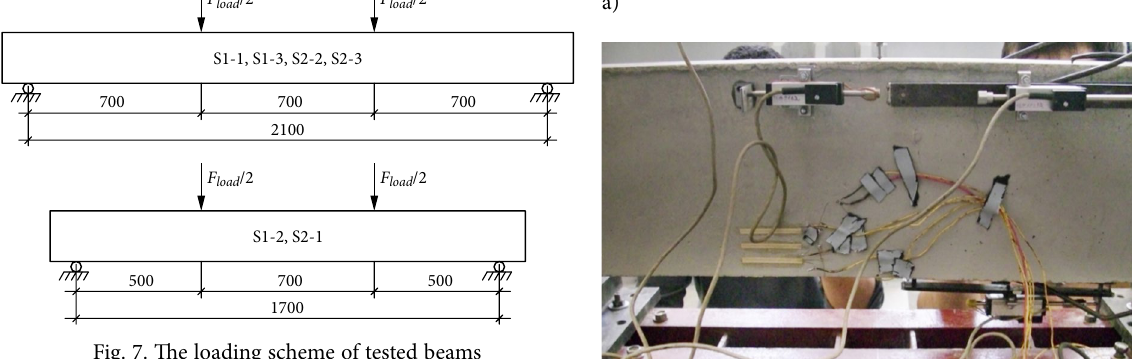
Fig. 7. The loading scheme of tested beams Table 1. Concrete and reinforcement parameters Beam ρ , % s 1